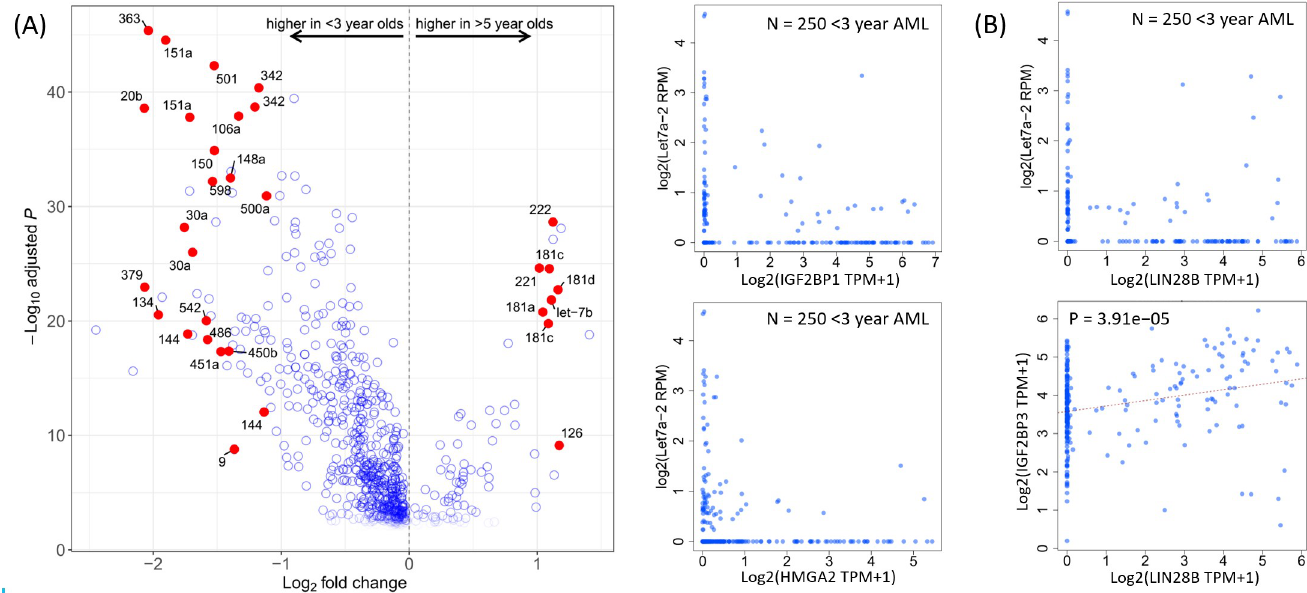
Fig 4. Micro RNAs in infant AML. ( A ) Volcano plot showing differentially expressed miRNAs in infants versus children > 5 years old. miRNAs to the left of the plot are up-regulated in infant AML. Some notable miRNAs are labeled individually. ( B ) The Let7 family of miRNAs is down-regulated in infant AML. Among Let7 family members, Let7a-2 exhibits particularly strong patterns of mutual exclusion with its putative target genes IGF2BP1 , LIN28B , and HMGA2 . Consistent with Let7 repression of IGF2BPs, LIN28B expression is correlated with IGF2BP3 expression.